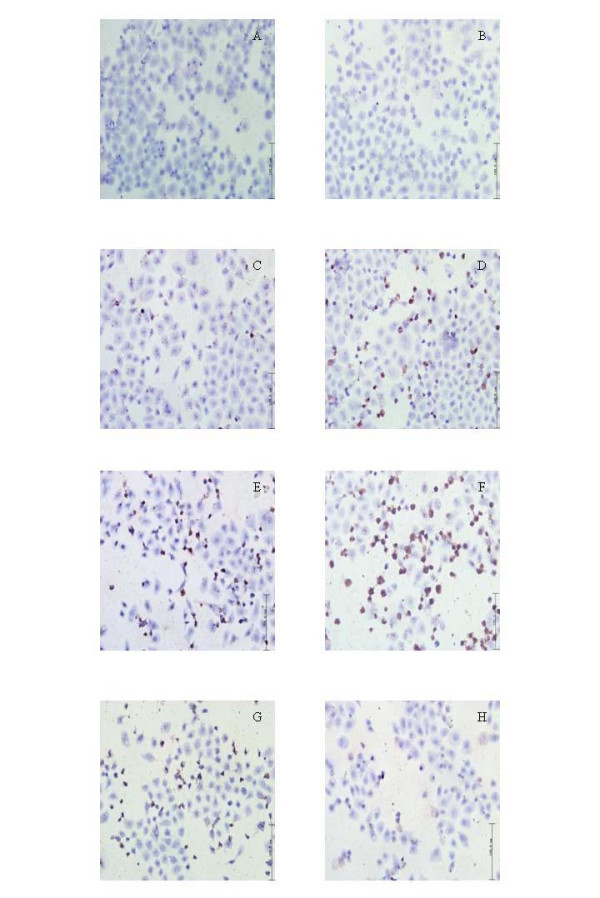
Detection of apoptosis by TUNEL: Staining. A549 cells were cultured on cover slides and transfected with different plasmids. Cells were allowed to recover in regular culture medium for 20 h after transfection, then exposed to normoxic or hypoxic atmosphere for 24 h with or without HEPES (25 mM) or the glycolytic inhibitor, 2-DG (5 mM) (n = 5 in each group). Only occasional normoxic cells were positive for TUNEL staining, (A). Hypoxia increased the amount of apoptosis of A549 cells, (D). Over-expression of HIF-1α further increased this pro-apoptotic effect of hypoxia, (F). However, siRNA suppression of HIF-1α expression rescued A549 cells from hypoxia-induced apoptosis, (C); but scrambled siRNA did not have this effect, (E). The pro-apoptotic effect of HIF-1α was also inhibited by the glycolytic inhibitor, 2-DG, (G). Increasing the buffering capacity of the culture medium with HEPES also inhibited the pro-apoptotic effect of HIF-1α, (H). Shown are representative photomicrographs from five independent experiments. Figure 9 was statistics of the five independent experiments. siRNA: A549 cells transfected HIF-1α siRNA vector, Mock: mock-transfected, HIF: A549 cells transfected with HIF-1α expression plasmid, HIF+2-DG: Cells transfected with HIF-1α expression plasmid and cultured with 2-DG, HIF+HEPES: Cells transfected with HIF-1α expression plasmid and cultured with medium containing HEPES. Scale bar: 100 μm.